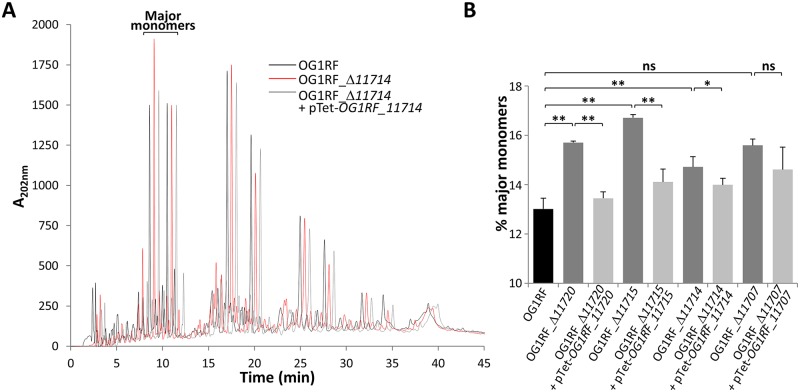
Peptidoglycan structural analysis of epa muants.Peptidoglycan was extracted from three biological replicates, digested with mutanolysin, reduced, and disaccharide-peptides were separated by reverse-phase HPLC. The traces shown represent averaged values from the three independent analyses A. A representative set of HPLC traces corresponding to the wild type OG1RF, mutant Δ11714 and complemented mutant is shown. For the sake of comparison, the UV values were normalised, using the intensity of the most abundant monomer as a reference. B. Statistical significance determined by unpaired t-test with Welch’s correction comparing the relative abundance of major monomers in peptidoglycan samples; ns, P>0.05; *P<0.05; **P<0.01.